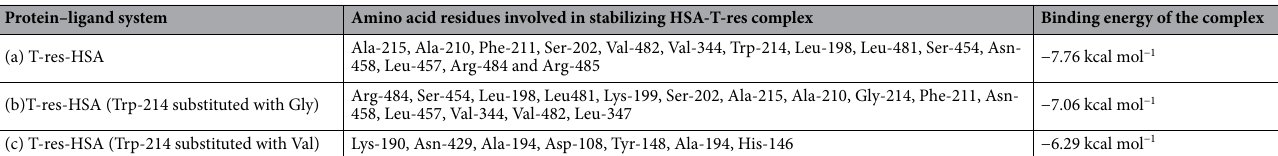
Amino acid residues involved in stabilizing HSA-T-res complex Binding energy of the